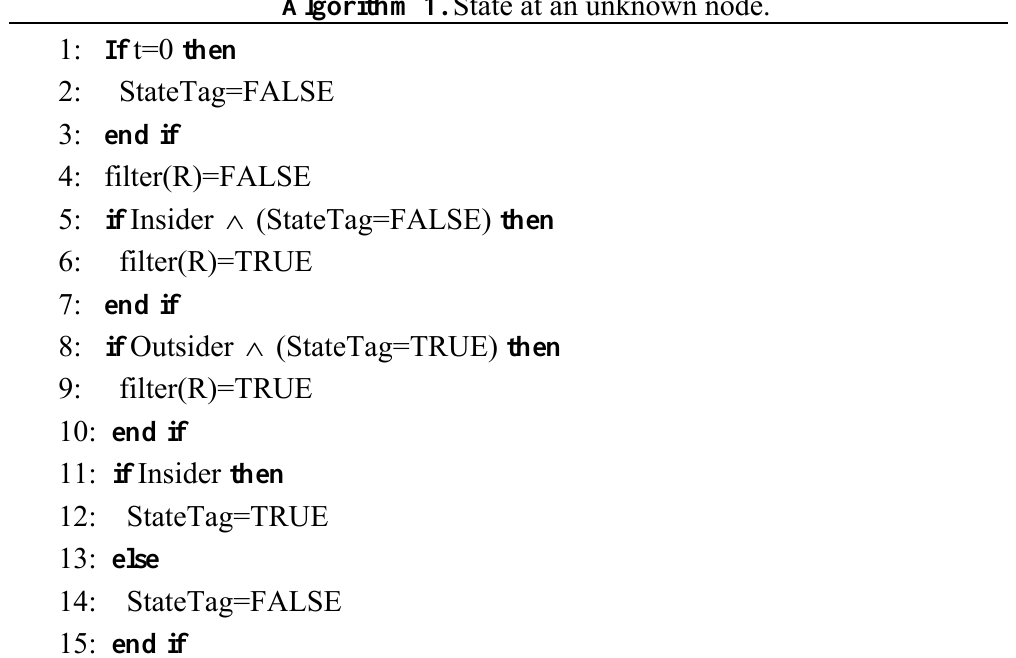
Algorithm 1. State at an unknown